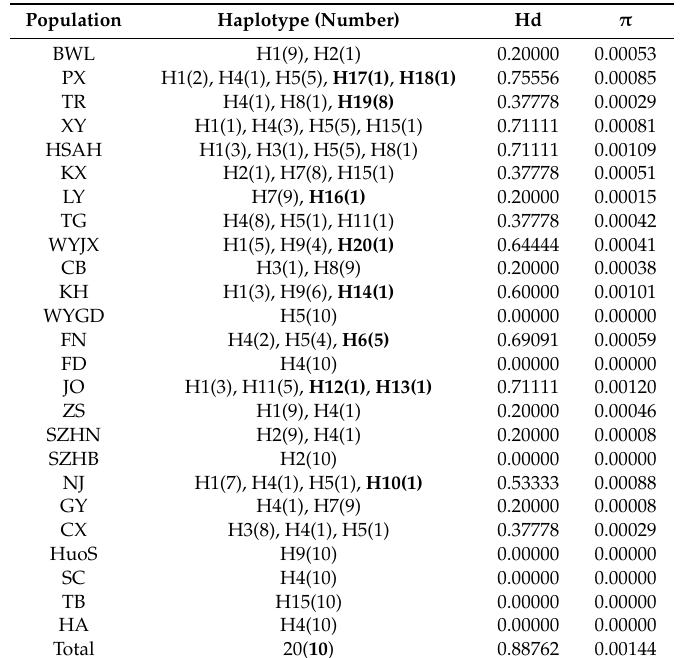
Table 2. Distribution and polymorphism of haplotypes in each population of L.